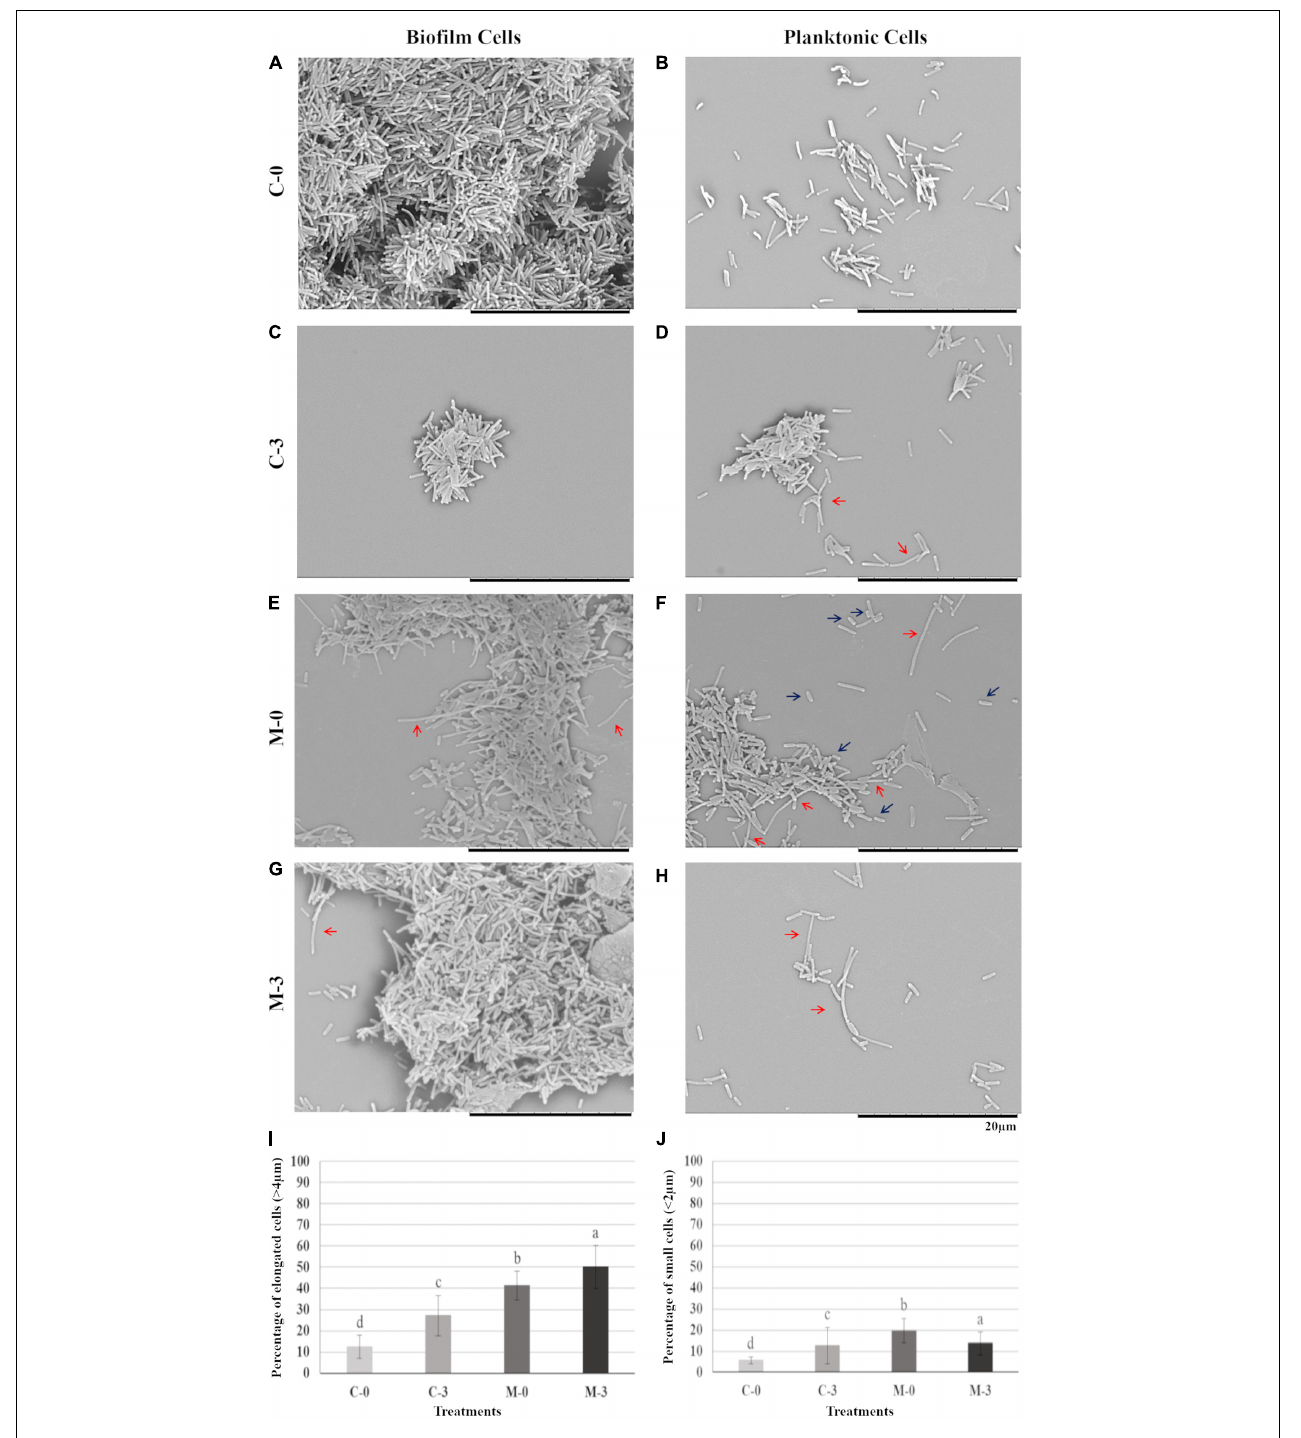
FIGURE 2 | Biofilm and planktonic behavior of Xf -EV and Xf - mqsR cells under copper stress. Left column: cells in biofilm. Right column: planktonic cells. (A,B) Representative pictures of C-0: Xf -EV cells without copper treatment. (C,D) Representative pictures of C-3: Xf -EV cells treated with 3 mM CuSO 4 . (E,F) Representative pictures of M-0: Xf-mqsR cells without copper treatment. (G,H) Representative pictures of M-3: Xf-mqsR cells treated with 3 mM CuSO 4 . Red arrows show elongated cells and blue arrows show short cells. Scale bar: 20 µ m. (I) Percentage of planktonic cells longer than 4.0 µ m. (J) Percentage of planktonic cells shorter than 2.0 µ m in the different treatments. Different letters on top of column bars indicate significant difference as analyzed by one-way ANOVA in SigmaPlot followed by Tukey’s HSD test ( p ≤ 0.05; n = 3 biological replicates, with 100 internal replicates each). C-0: Xf -EV cells without copper treatment; C-3: Xf -EV cells treated with 3 mM of CuSO 4 ; M-0: Xf - mqsR cells without copper treatment; M-3: Xf - mqsR cells treated with 3 mM of CuSO 4 .